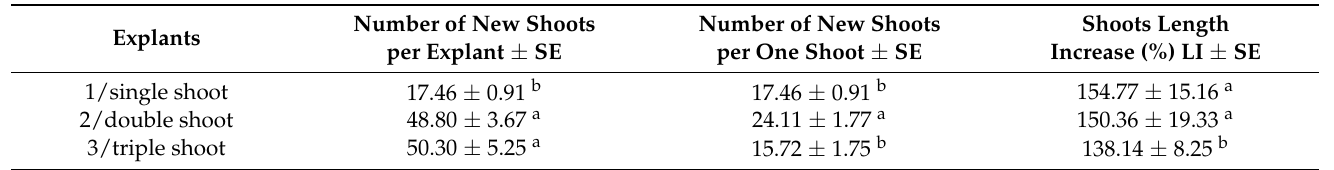
Table 3. The influence of the type of the plant explant on Linnaea borealis var. borealis shoot multiplication in the liquid MS